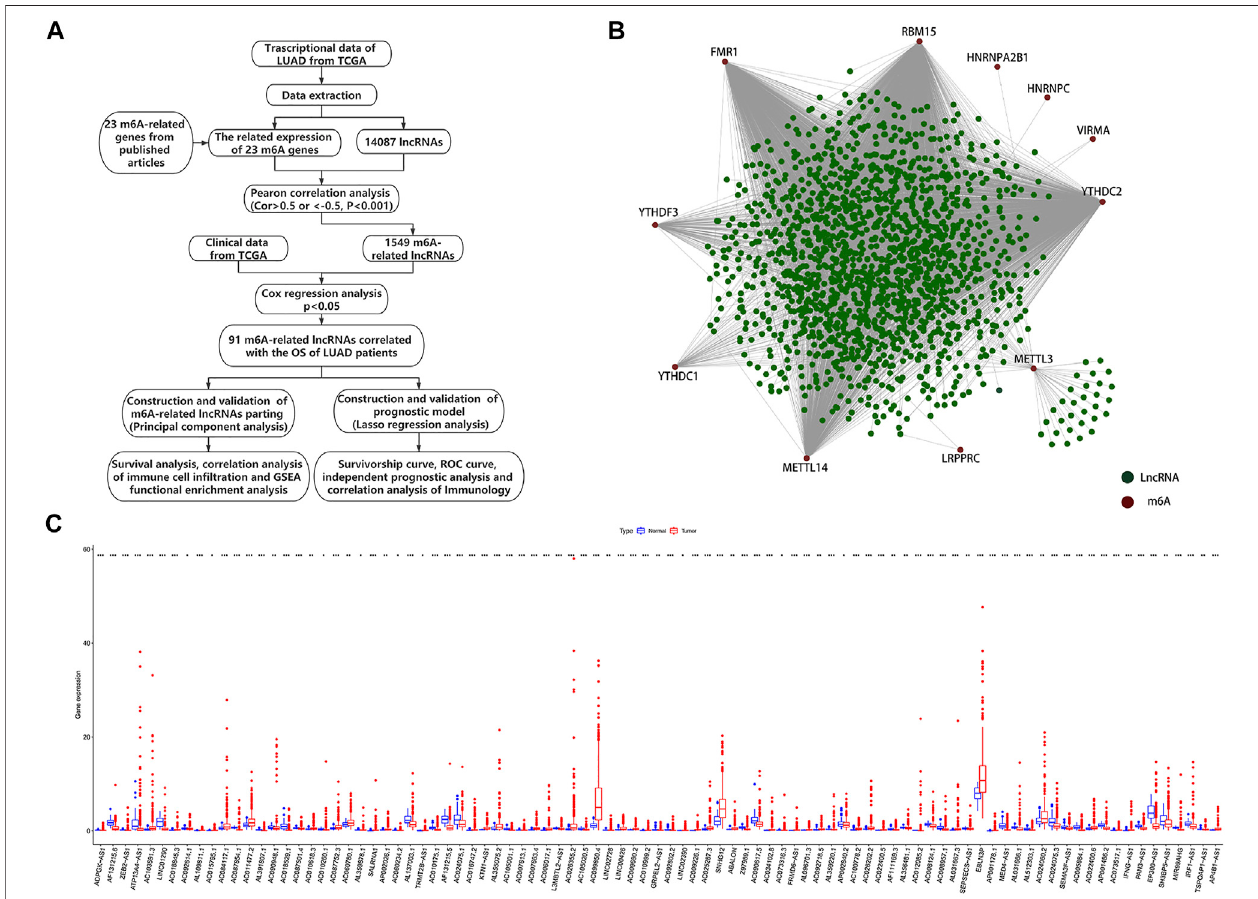
FIGURE1| Identi fi cationofm6A-relatedlncRNAsinLUADpatients. (A) Study fl owchart. (B) Networkofcorrelationsbetweenm6A-relatedgenesandm6A-related lncRNAs. (C) Expression chamber diagram of 91 prognostic m6A-related lncRNAs (* p < 0.05; ** p < 0.01; *** p < 0.001).